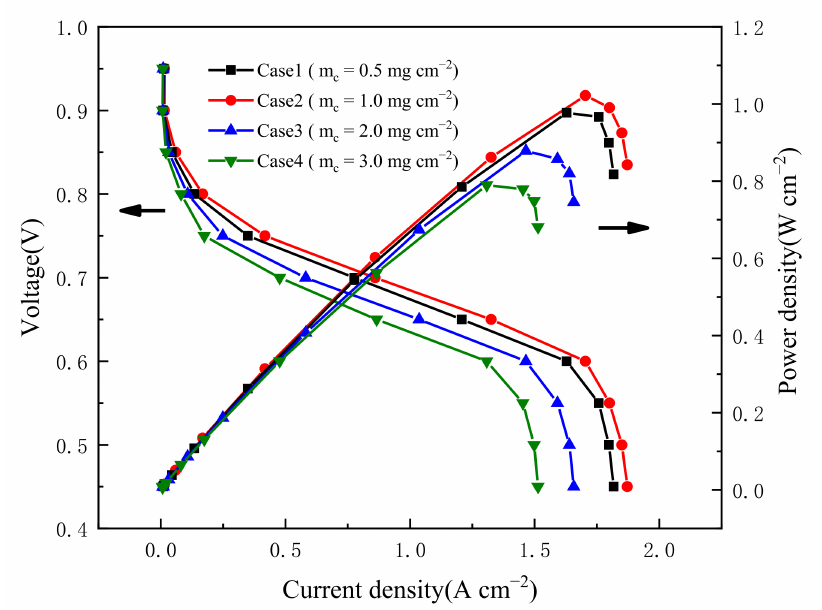
Figure 6. Effect of carbon loading on cell